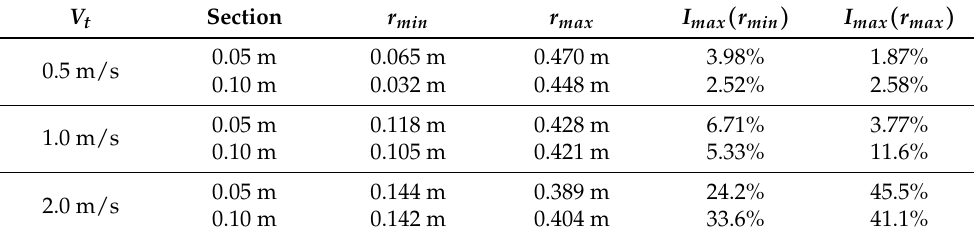
Figure 4. Minimum (MIN), maximum (MAX), and average (MEAN) values of parameters from the CFD computer model for sections located (0.05 m) and (0.1 m) under the rotors’ plane: ( a ) velocity magnitude; ( b ) turbulent intensity. Table 1. Parameters in the sections analyzed for selected velocity magnitude